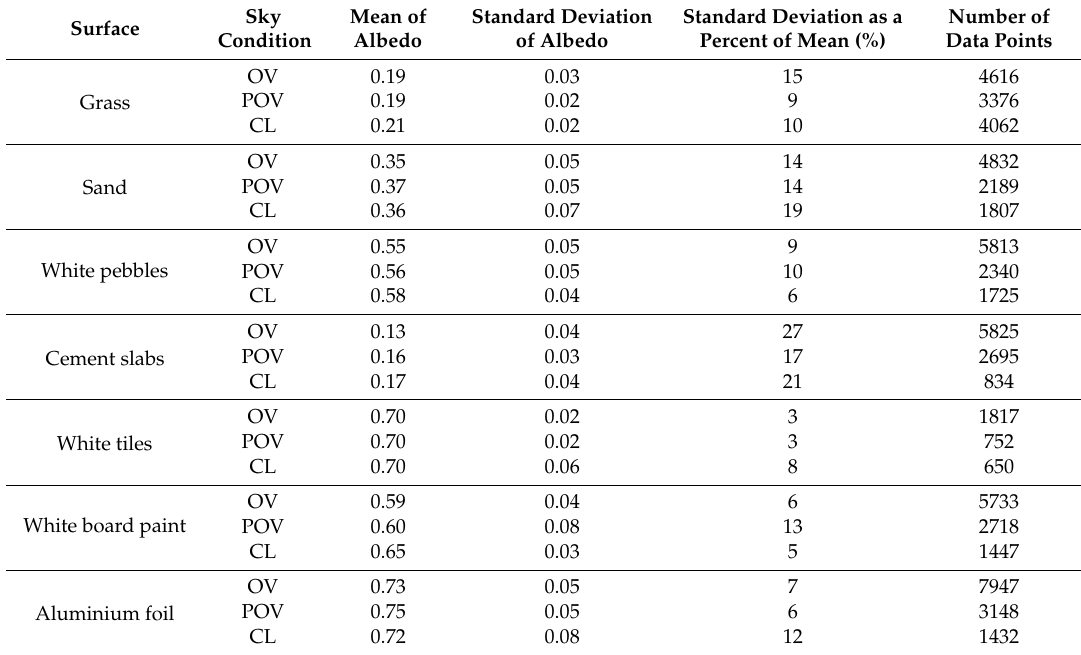
Table 2. Data validation of albedo recorded for each material under varying sky